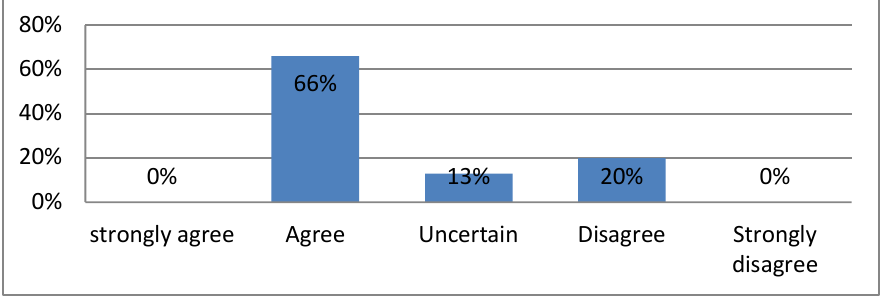
Figure 10 : service provider after seeing the advertisement